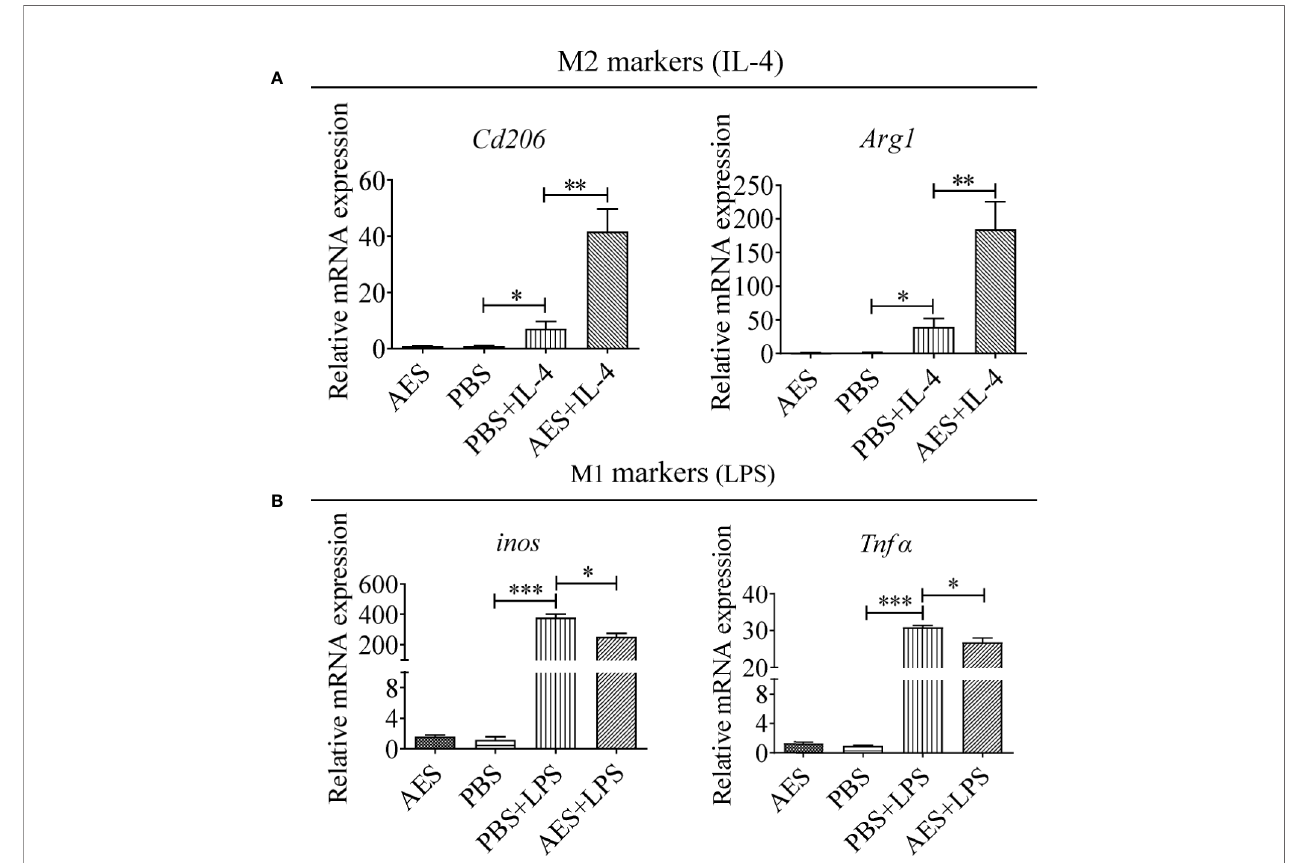
FIGURE 3 | T. spiralis AES enhanced IL-4-induced RAW264.7 macrophage M2 polarization and decreased LPS-induced M1 polarization. RAW264.7 cells were pretreated with T. spiralis AES prior to stimulation with IL-4 or LPS. (A) The mRNA levels of M2-associated Cd206 and Arg1 in IL-4 stimulated RAW264.7 were analyzed by qRT-PCR. (B) The mRNA levels of M1-associated inos and Tnf a in LPS-stimulated RAW264.7 were analyzed by qRT-PCR. The relative expression level was compared with PBS control group as baseline. Experiments were repeated in triplicate. Data are expressed as means ± SEM. * P < 0.05, ** P < 0.01, *** P < 0.001; ns = not signi fi